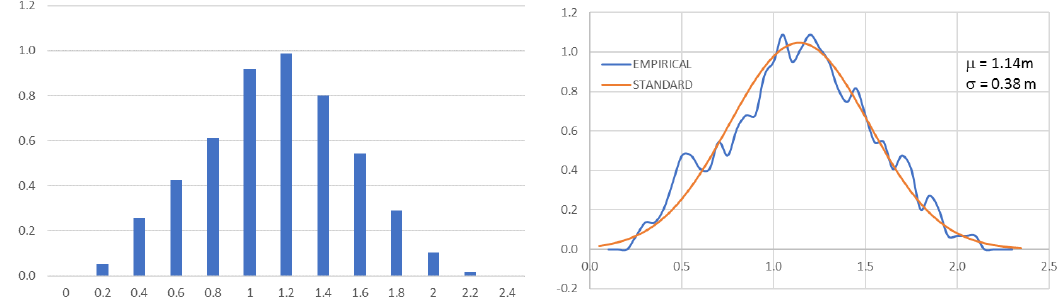
Figure 9. Histogram of the relative frequency of the ensemble projections at epoch 2100 (left) and the standard adjusted PDF (right) with a standard deviation of 38 cm.